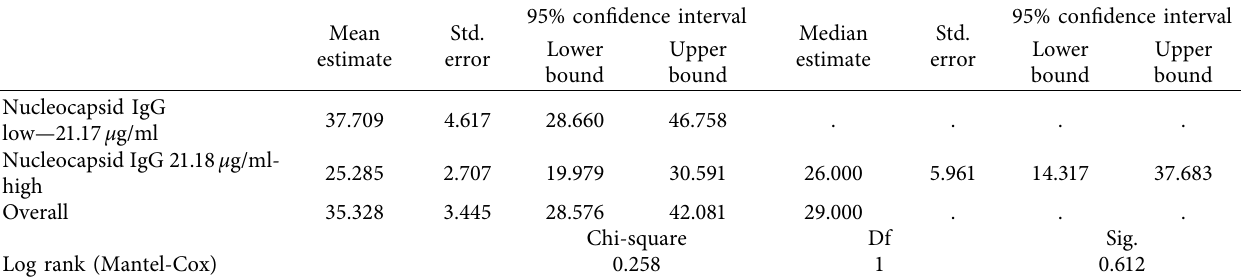
Figure 1: (a) Survival of patients since receiving COVID-19 convalescent plasma infusion: nucleocapsid protein domain. (b) Survival of patients since receiving COVID-19 convalescent plasma infusion: RBD domain. (c) Survival of patients since receiving COVID-19 convalescent plasma infusion: S1 subunit domain. (a) Kaplan–Meier estimates of the mean times to death following plasma transfusion within the nucleocapsid protein domain. Time since convalescent plasma transfusion is the time-dependent variable on the x -axis with cumulative survival plotted on the y -axis. Low antibody concentration data is represented in blue and high antibody concentration is represented in green. (b) Kaplan–Meier estimates of the mean times to death following plasma transfusion within the receptor-binding domain (RBD). Time since convalescent plasma transfusion is the time-dependent variable on the x -axis with cumulative survival plotted on the y -axis. Low antibody concentration data is represented in blue and high antibody concentration is represented in green. (c) Kaplan–Meier estimates of the mean times to death following plasma transfusion within the S1 subunit domain. Time since convalescent plasma transfusion is the time-dependent variable on the x -axis with cumulative survival plotted on the y -axis. Low antibody concentration data is represented in blue and high antibody concentration is represented in green. Table 3: Means and medians for survival time for the nucleocapsid protein